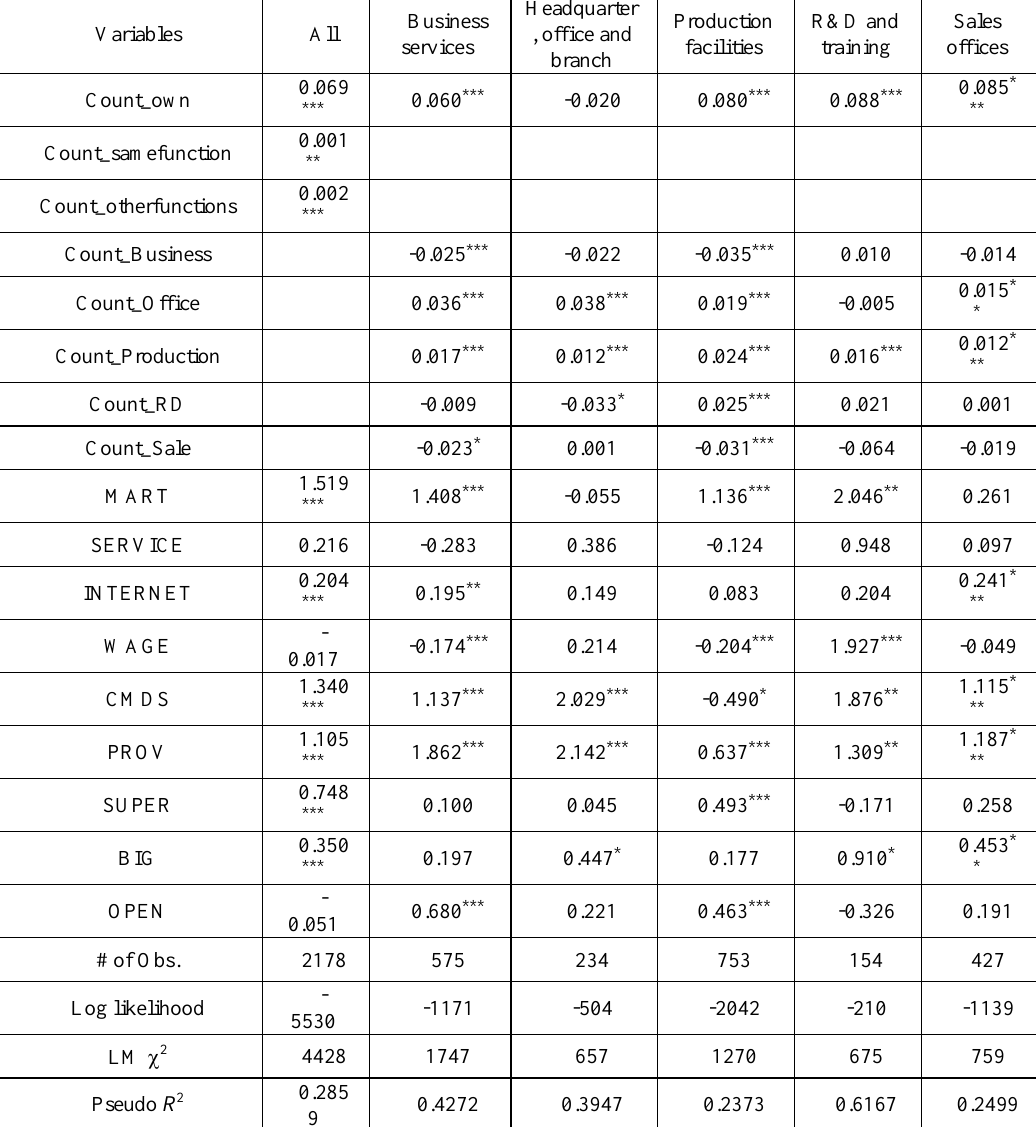
Table 1 : Results from the Conditional Logit Model Estimations Variables